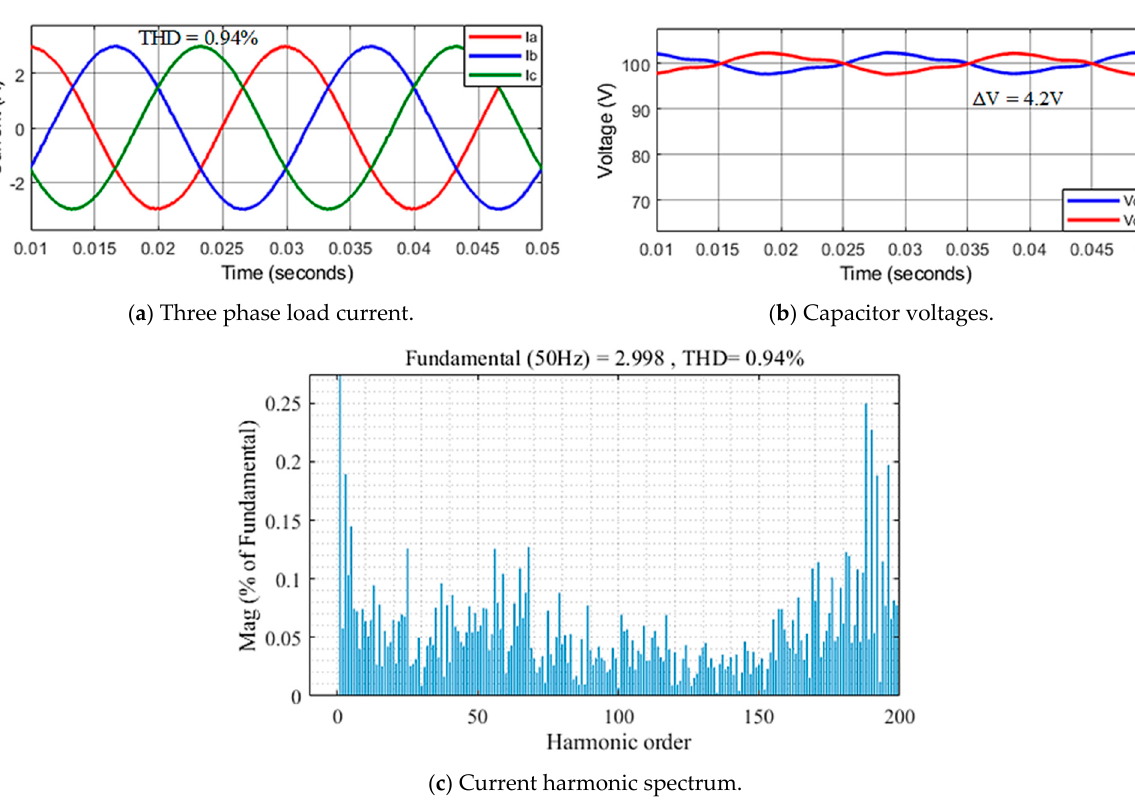
Figure 10. The steady − state response of asymmetric inverter using improved MPC algorithm.